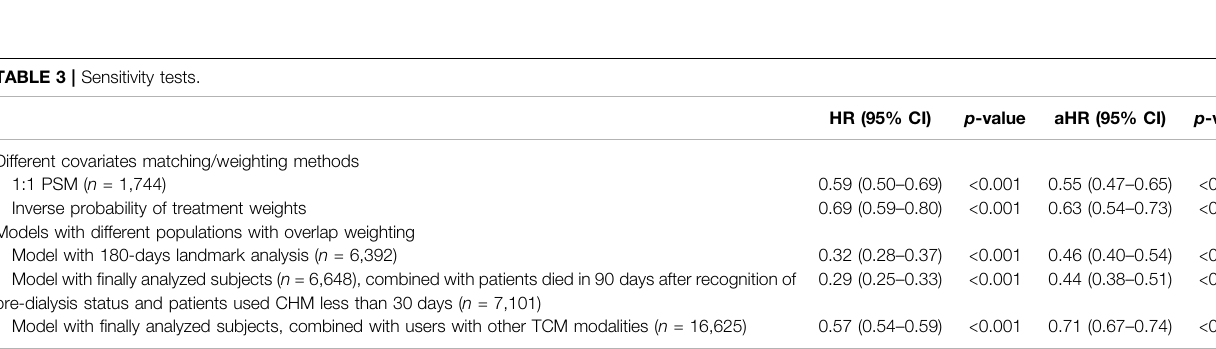
TABLE 3 | Sensitivity tests.